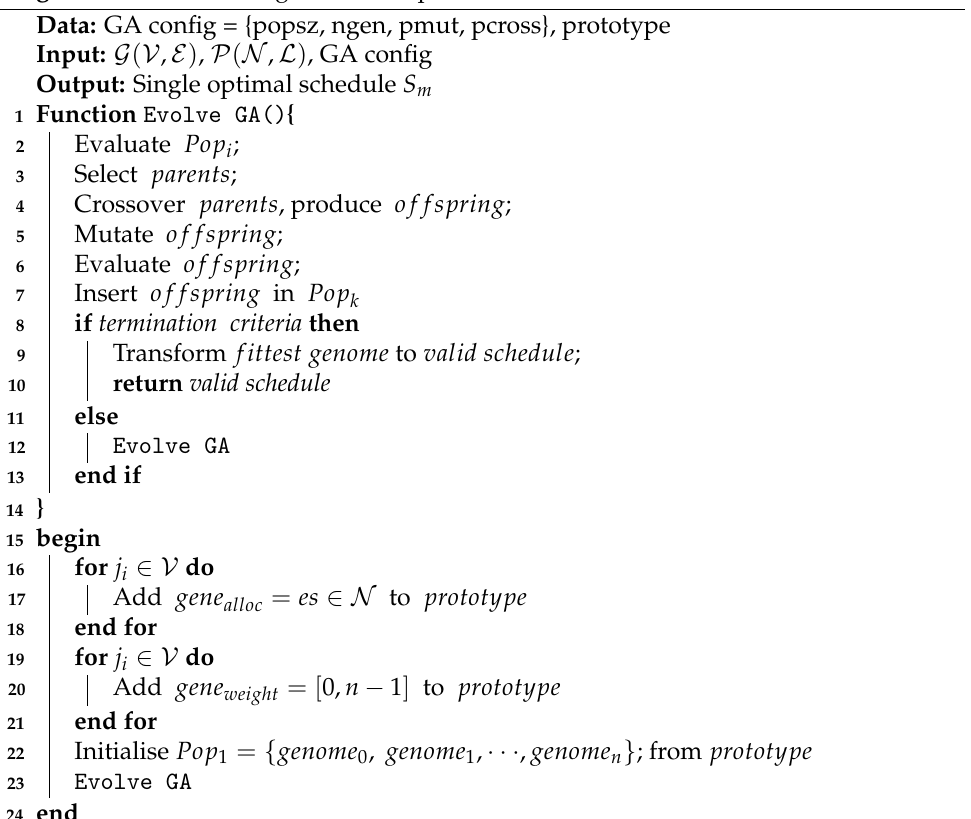
Algorithm 1: Genetic Algorithm Adaptation for TTNoC